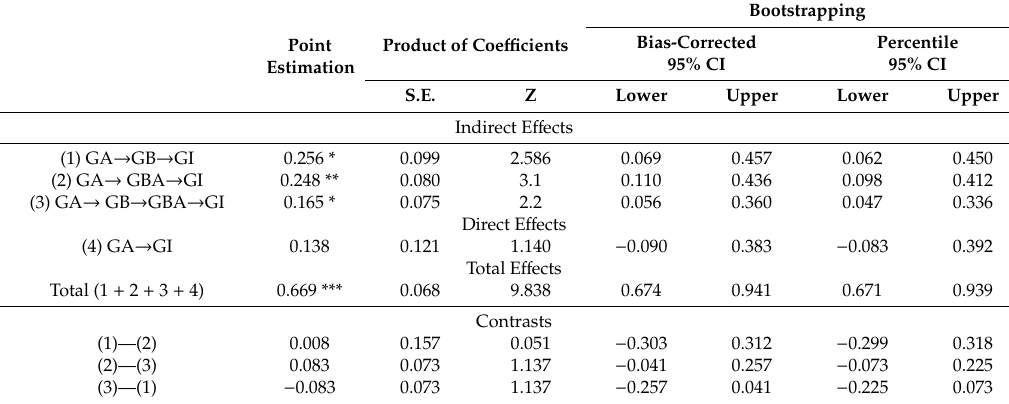
Table 6. The mediation results of this